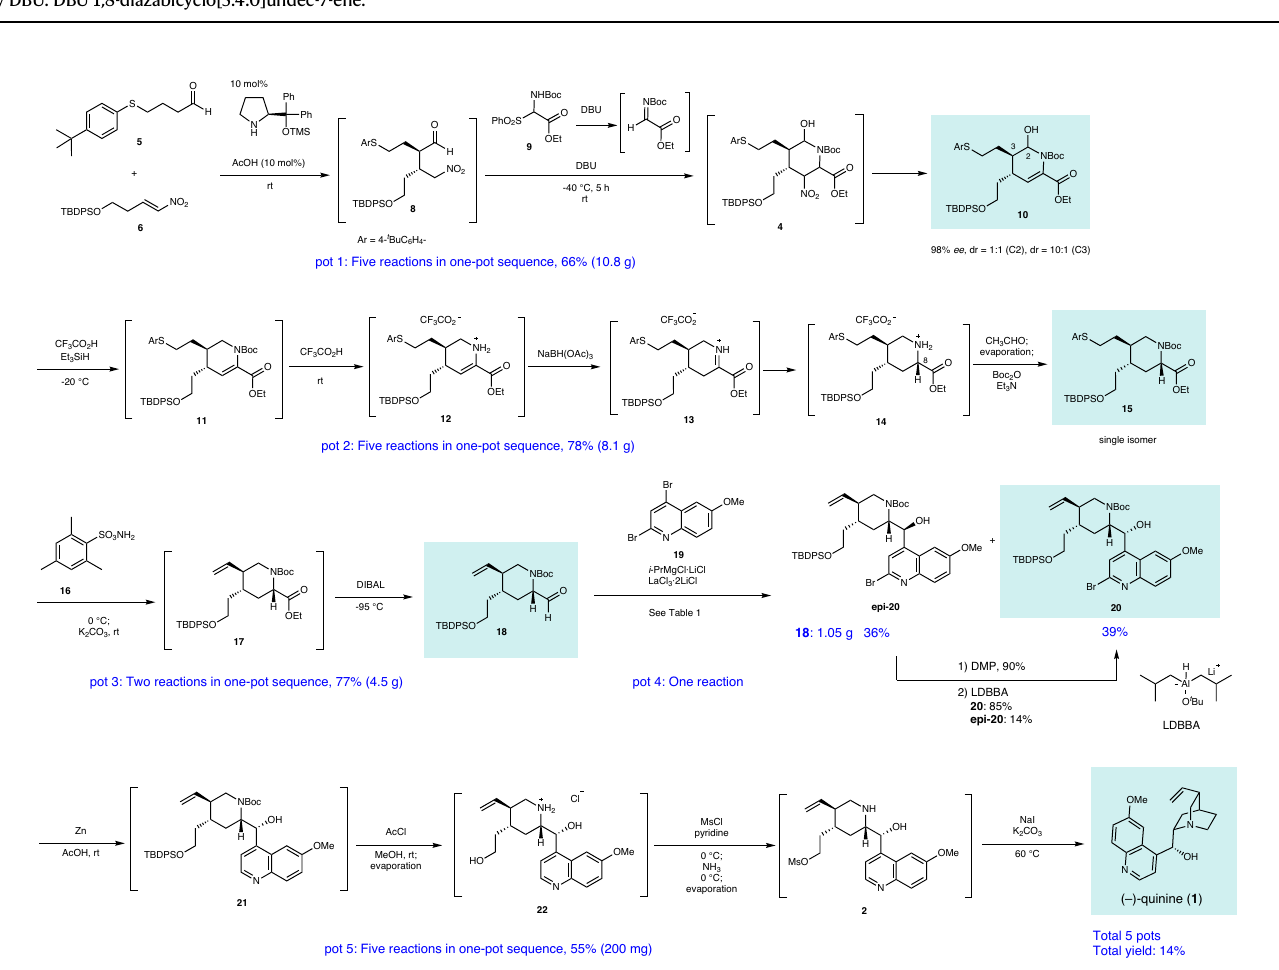
Nature Communications| (2022)